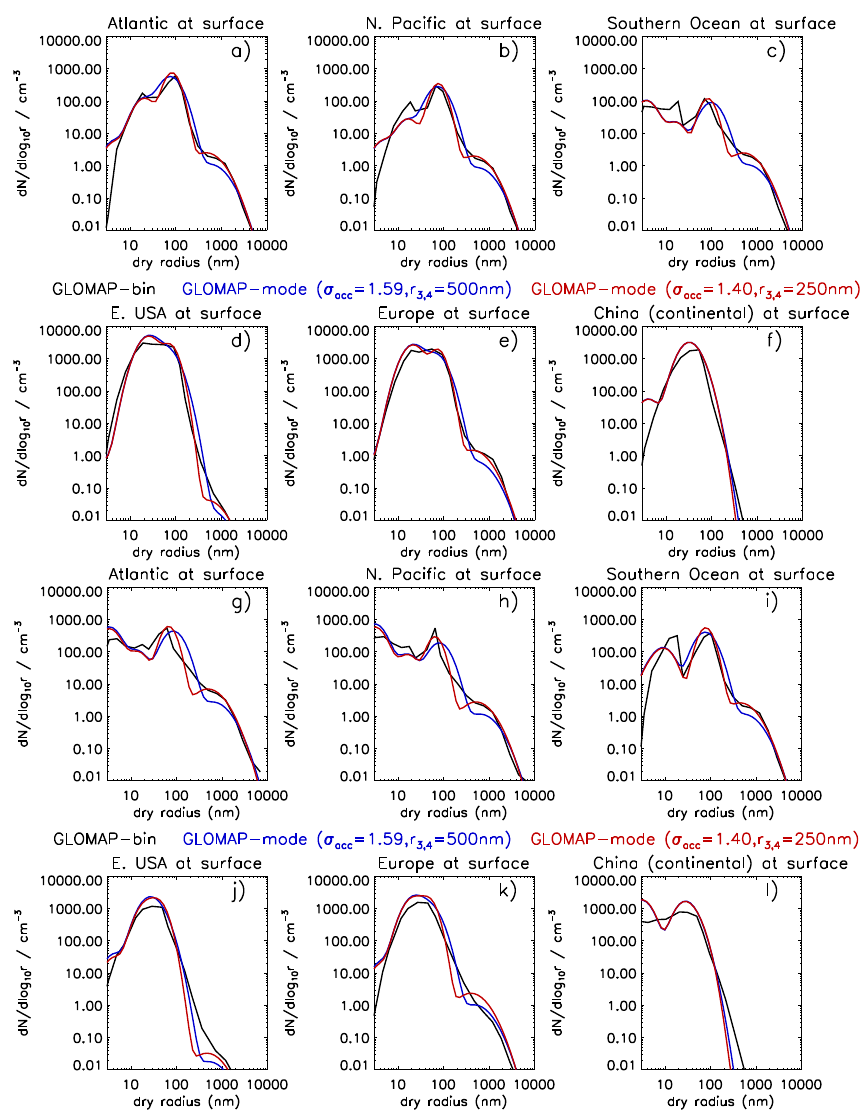
Fig. 1. Surface size distributions simulated by GLOMAP-bin (black) and the standard (v6I) GLOMAP-mode run (blue) and improved (v6R) GLOMAP-mode run (red). Number size distributions (d N / d log r ) are shown for three marine and three continental locations in June (a–f) and December (g–l) The exact locations are as follows: Atlantic (40 ◦ W, 43 ◦ N), N. Pacific (163 ◦ W, 43 ◦ N), Southern Ocean (163 ◦ W, 38 ◦ S), E.